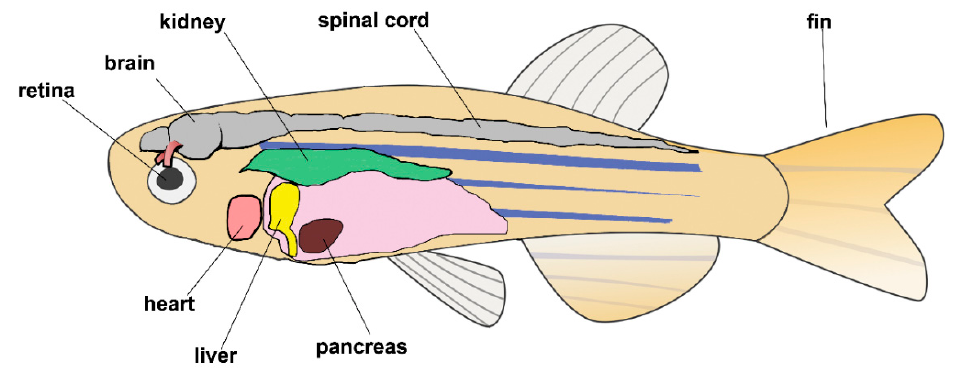
Figure 5. Regeneration in zebrafish. Schematic drawing of a zebrafish adult showing organs used for regeneration studies.